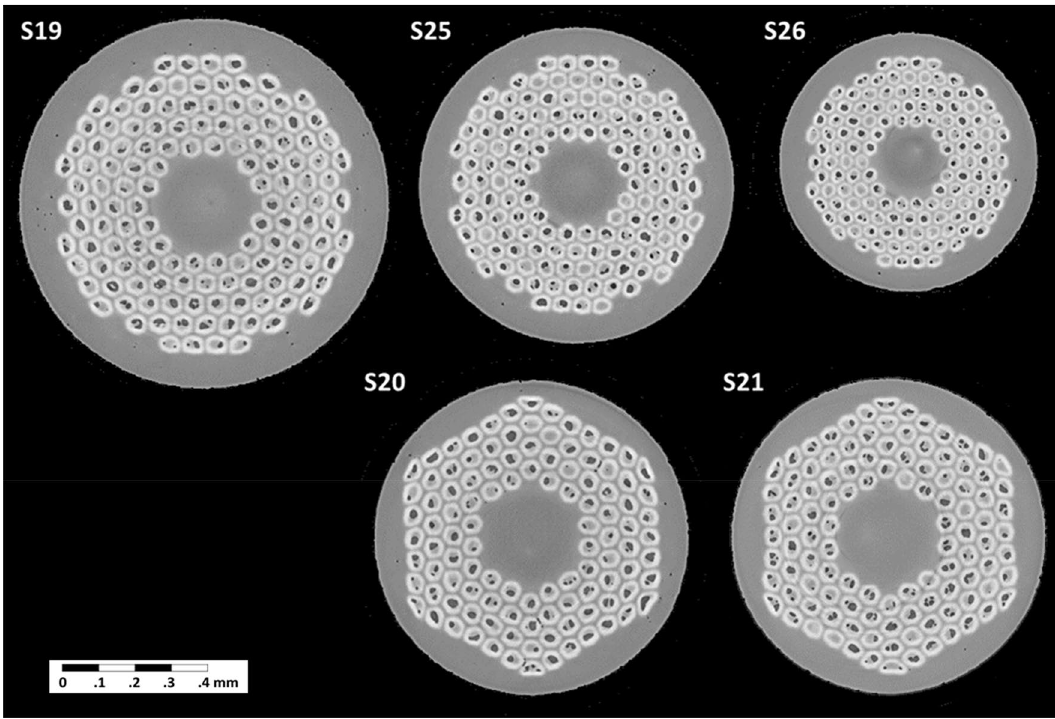
Figure 1. X-ray tomography cross section of the Nb 3 Sn RRP wires tested at the ESRF